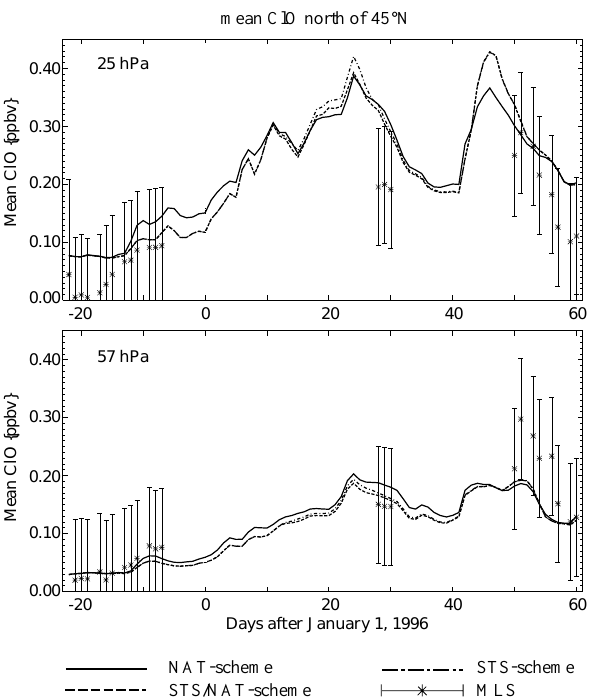
Fig. 6. Temporal change of the ClO x (: = Cl + ClO + 2 Cl 2 O 2 +2 Cl 2 +HOCl+OClO) mixing ratio (ppbv) averaged over the area north of 45 ◦ N on the model levels (bottom frame) 57 hPa and (top frame) 25 hPa. Results are presented for the time pe- riod between 10 December 1995, and 29 February 1996, simulated in the model experiments performed with the NAT-, the STS-, the STS/NAT- and the BIN-scheme,